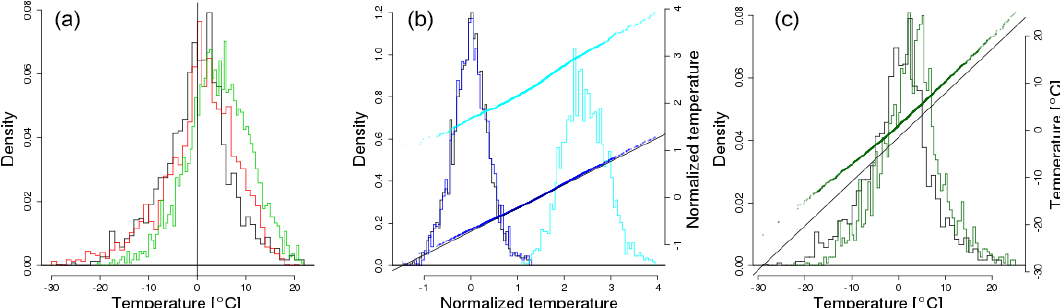
Figure 2. (a) Histograms of initial (black) reanalysis data (Dee et al., 2014) from 1979–2016 winter (DJF) from the location that includes Chicago. The initial LENS model data from the same period are shown in red. The final years, 2059–2096, of LENS model data are shown in green. (b) Normalized temperature distributions. The distribution of normalized reanalysis temperature is shown in black. The distribution (cid:16) (cid:17) after applying the shape transformation e G − 1 is shown in dark blue. These values are shifted by m y ( d,t f ) − m y ( d,t p ) and e G d,t p ( e X ( d,t p )) d,t f r y ( d,t f ) scaled by (light blue). (c) The initial normalization to the reanalysis is undone, yielding a distribution for the transformed observations r y ( d,t p ) (dark green) and are compared to the untransformed reanalysis (black). Panels (b) and (c) also show qq-plots on the right y axis to make it easier to see changes in the tails of the